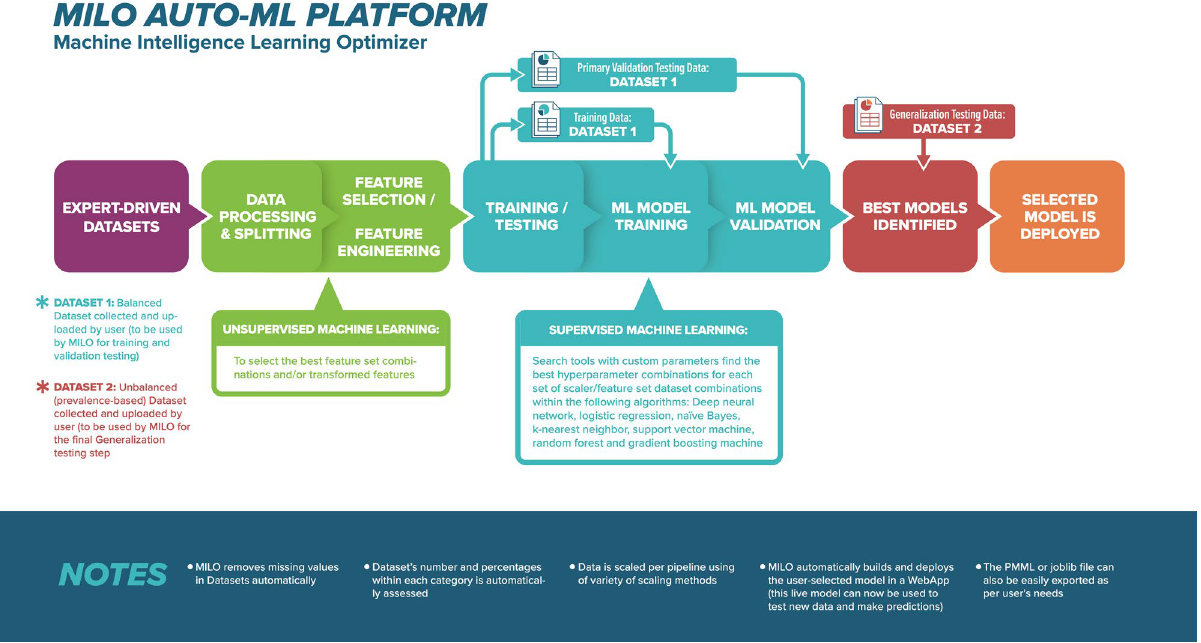
Figure 2. Machine intelligence learning optimizer Fig. 1. The MILO auto-machine learning (ML) infrastructure consists of beginning with two datasets: ( a ) balanced data (Dataset A) set used for training and initial validation, and ( b ) an unbalanced dataset (Dataset B) for generalization/secondary testing. MILO initially removes the missing values followed by providing several scaling options for the given dataset which is then assessed by the software. Unsupervised ML is then used for feature selection and feature engineering. The generated models are then trained on a subset (80%) of dataset A (depicted as Dataset 1 in the image above) and then initially tested with the remaining subset (20%) of Data Set A during its supervised ML stage. Following this training/ initial validation stage, each of the ML models generated in this stage are then secondarily tested on Dataset B (depicted as Dataset 2 in the image above) for generalization testing. Selected models can then be deployed thereafter as joblib files. For this study, we imported the study data into MILO using COVID-19 status as the outcome measure for analysis. The following functions are then performed automatically by